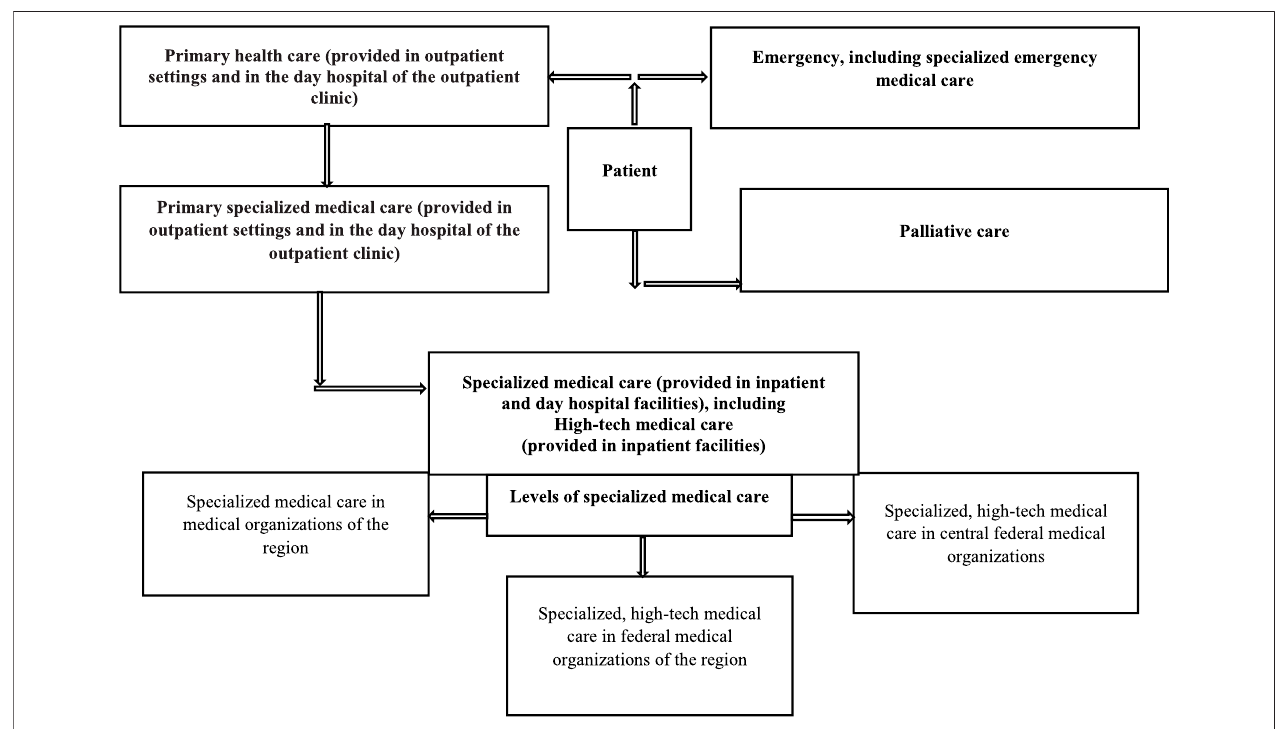
FIGURE 1 | Principles of medical care for patients with rare diseases at the regional and federal levels in Russia.